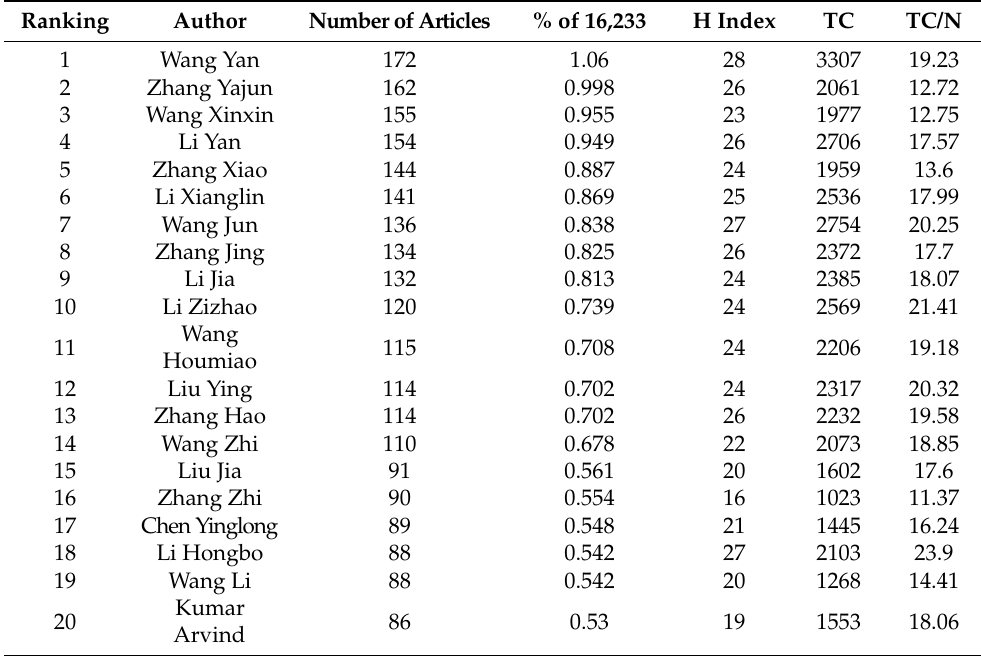
Table 2. The top 20 authors by number of articles published from 2000 to